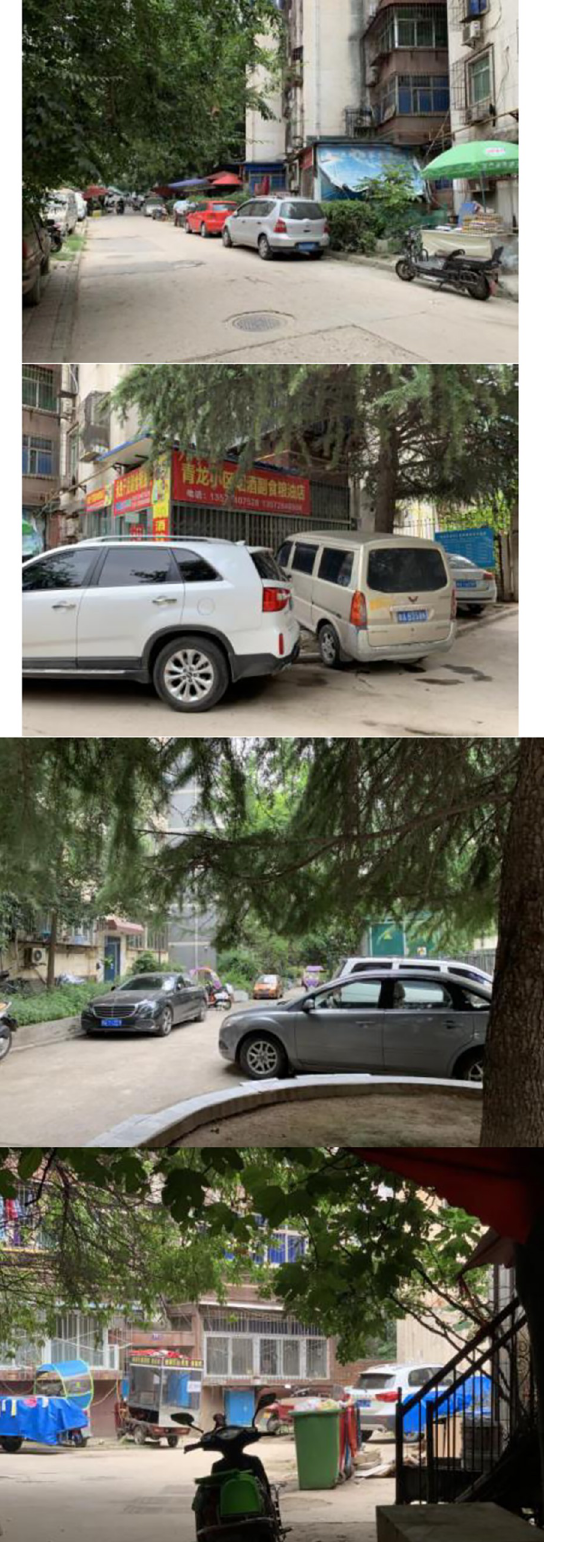
Fig 10. The phenomenon of random